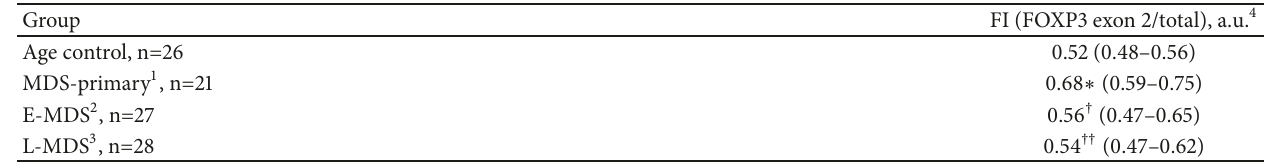
Table 5: The ratio of FOXP3 exon 2 fluorescence intensity to FOXP3 total fluorescence intensity in CD3 + CD4 + FOXP3 + cells from the peripheral blood of the patients with MDS and age-matched healthy